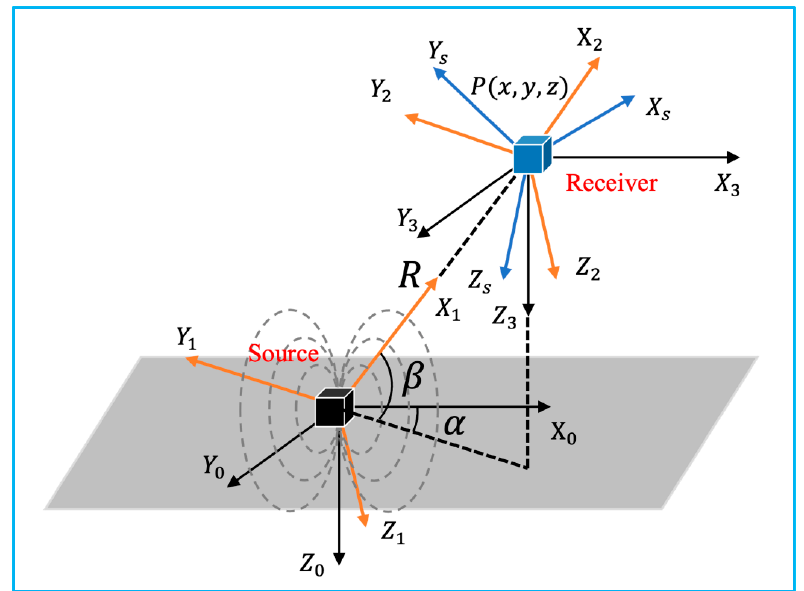
Figure 3. Coordinate systems involved in the 3D electromagnetic tracking (adapted from [21]).